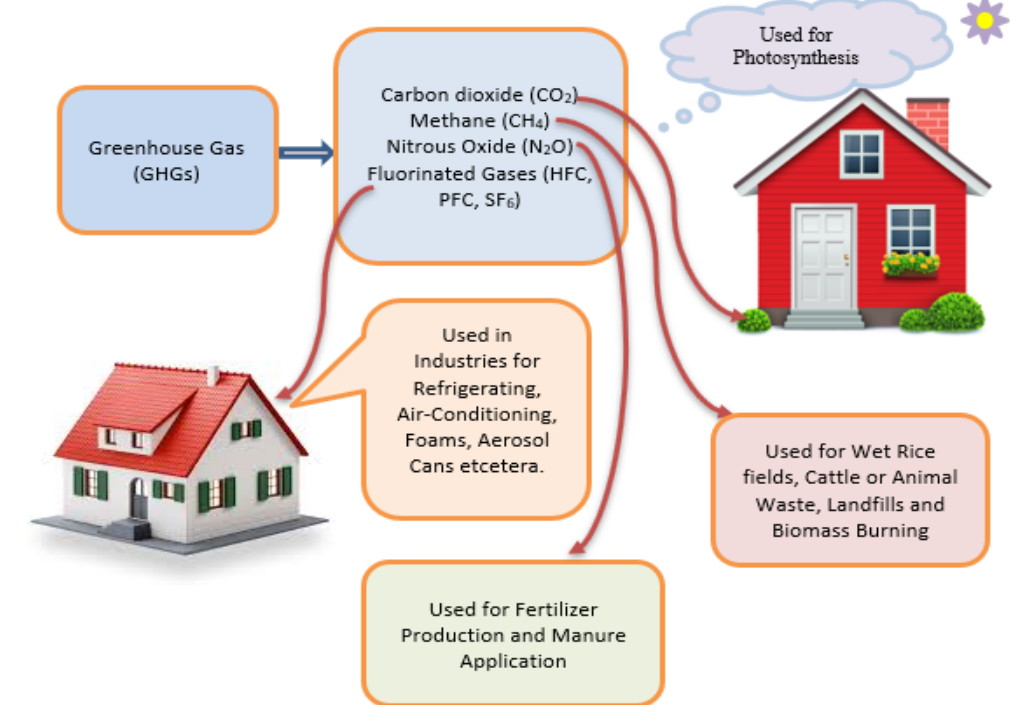
Figure 3. Implementation of GHG components to green building dynamic systems.